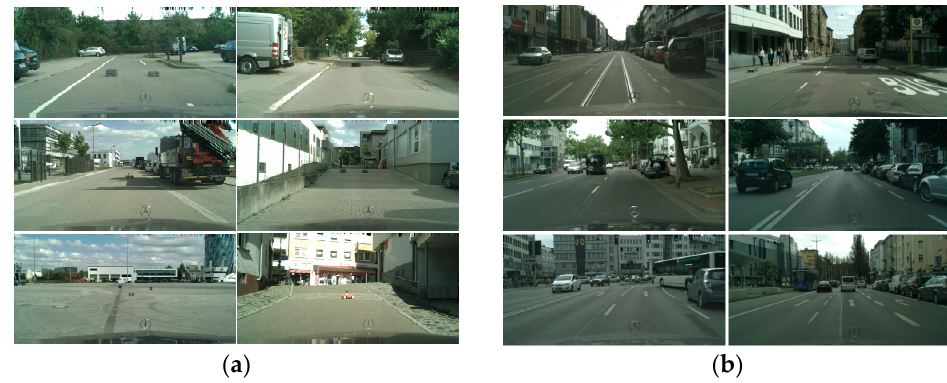
Figure 7. Image examples of datasets: ( a ) the Lost and Found dataset; ( b ) the Cityscapes dataset.